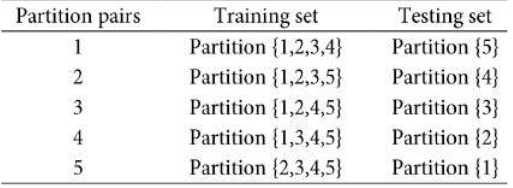
Table 2. Training-testing partition pairs using five folds cross-validation